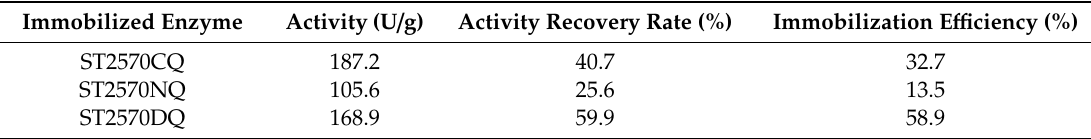
Table 3. The activity recovery rate and immobilization e ffi ciency of ST2570 immobilized by resin D380. Immobilized Enzyme Activity (U / g) Activity Recovery Rate